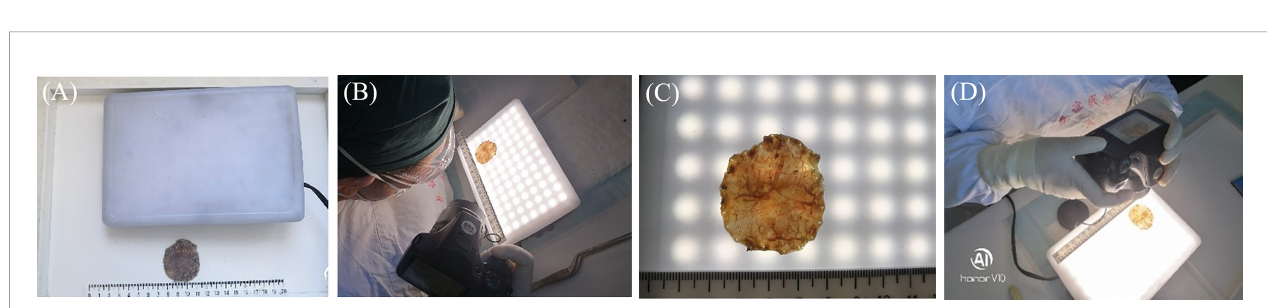
FIGURE 3 | Macroscopic observation of the endoscopic submucosal dissection (ESD) specimen by light transmission-assisted pathological examination. (A) The light-emitting diode (LED) lamp and formalin- fi xed ESD specimen. (B) The ESD specimen is placed on the surface of the LED lamp. (C, D) The LED light is transmitted through the ESD specimen, and the surface structure and vascular changes are present and